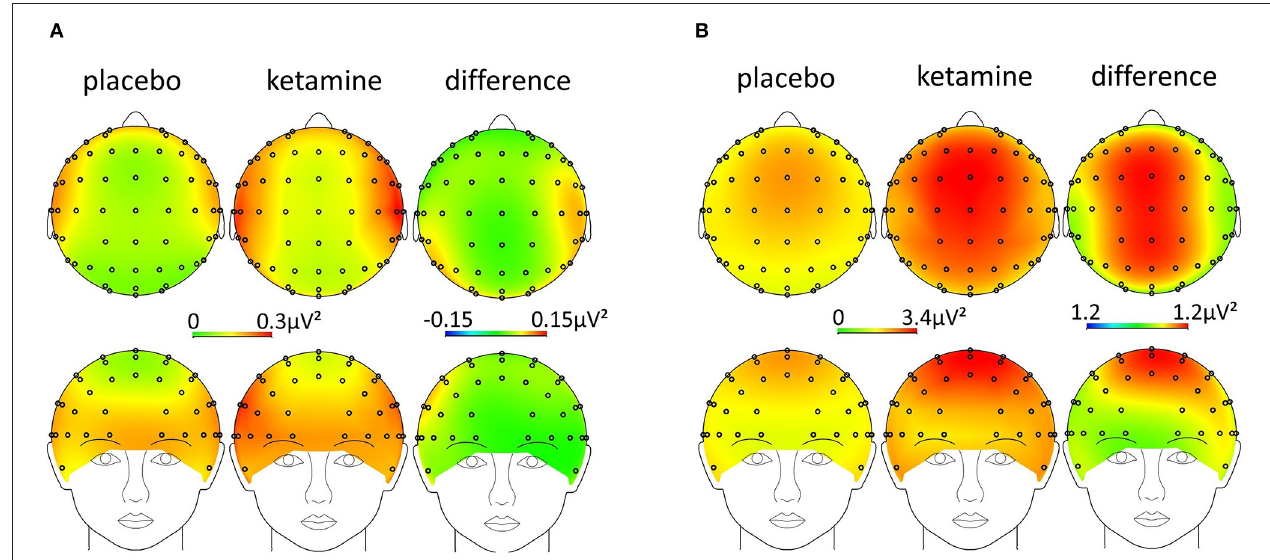
FIGURE 4 | Scalp-topography [ketamine, placebo, and difference (ketamine-placebo)] in the (A) gamma- (30–40Hz) and (B) theta-band (4–8Hz).